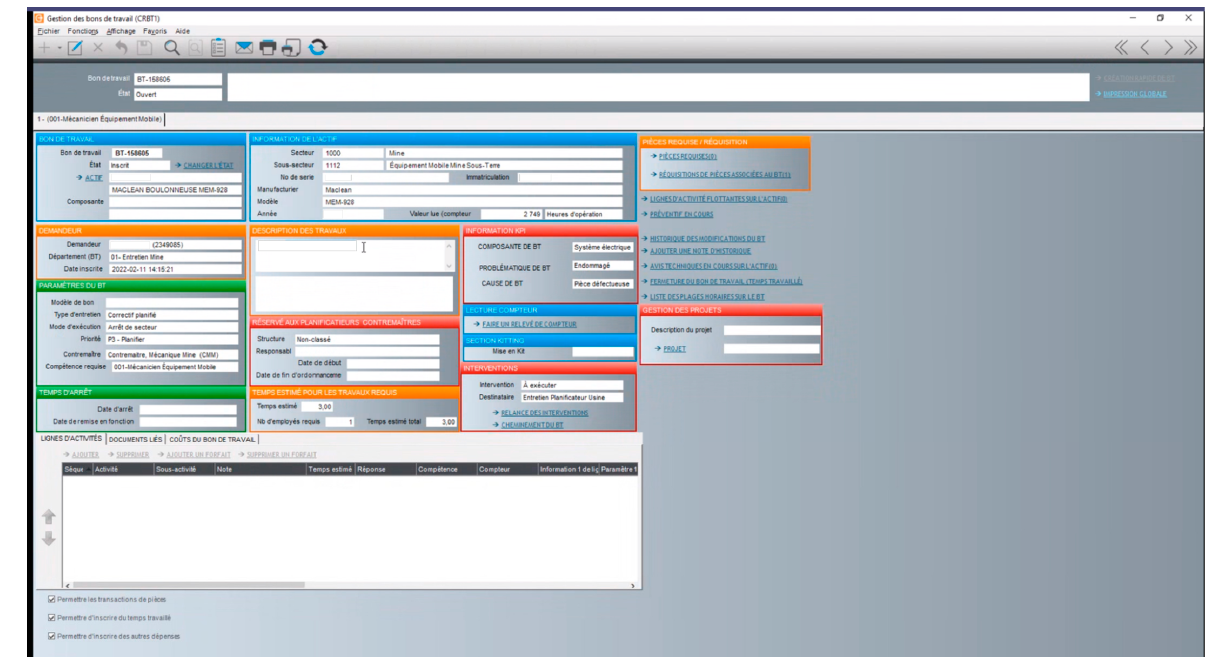
Figure A1. JDEdwards example work order.